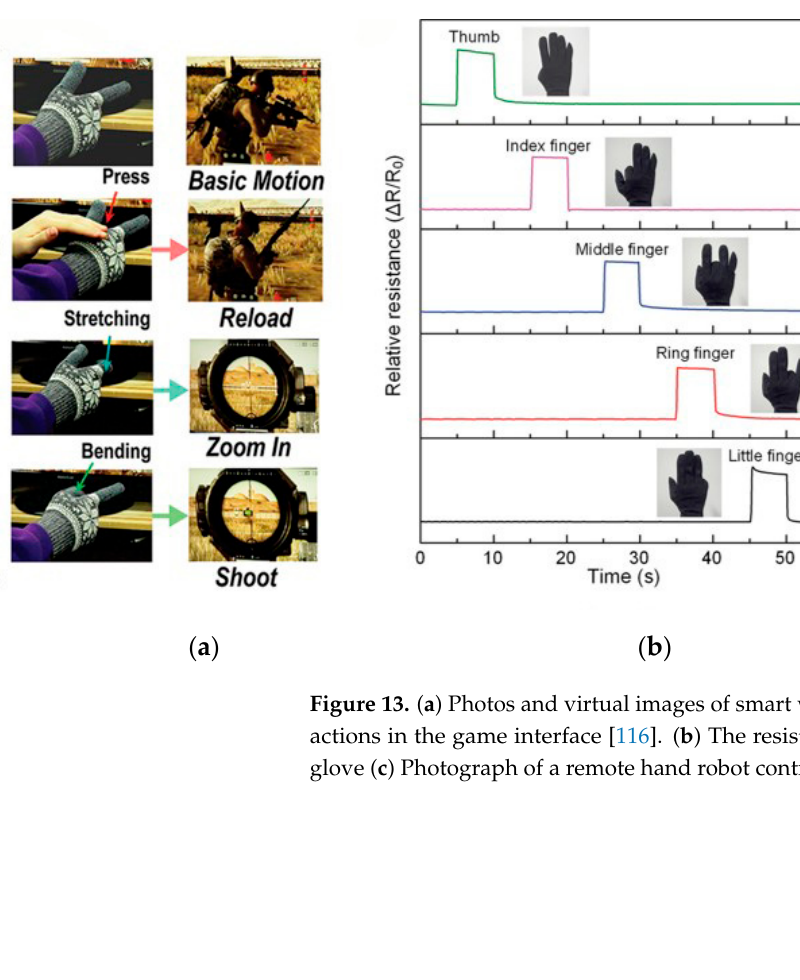
Figure 14. A data glove with ten fiber strain sensors fixed [117]. 6. Conclusions and Outlook In summary, this review summarized the recent developments in fiber- and yarn- based strain sensors, from commonly used conductive materials to common preparation methods (spinning and coating). The structural designs of strain sensors are introduced in detail, including internal structures (uniform, coaxial, porous, and hollow structures), surface microstructures (microcrack and wrinkled structures) and macrostructures (wrapped, braided, and winding structures). The internal structure design lowers the per- colation threshold of materials, and the surface microstructure design improves the per- formance of the sensor. Each macrostructure has its own characteristics. In addition, the